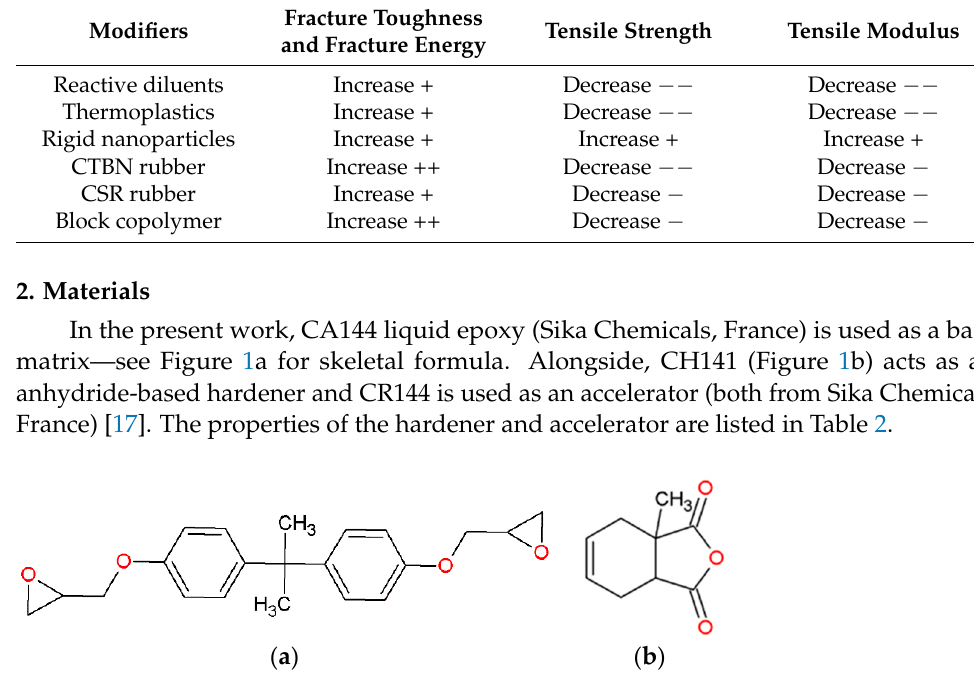
Figure 1. ( a ) Molecular structure of CA144 (diglycidyl ether of bisphenol–A) and ( b ) CH141 (tetrahydromethylphthalic anhydride). Table 2. Properties of anhydride hardener, and accelerator used in the present work [17].